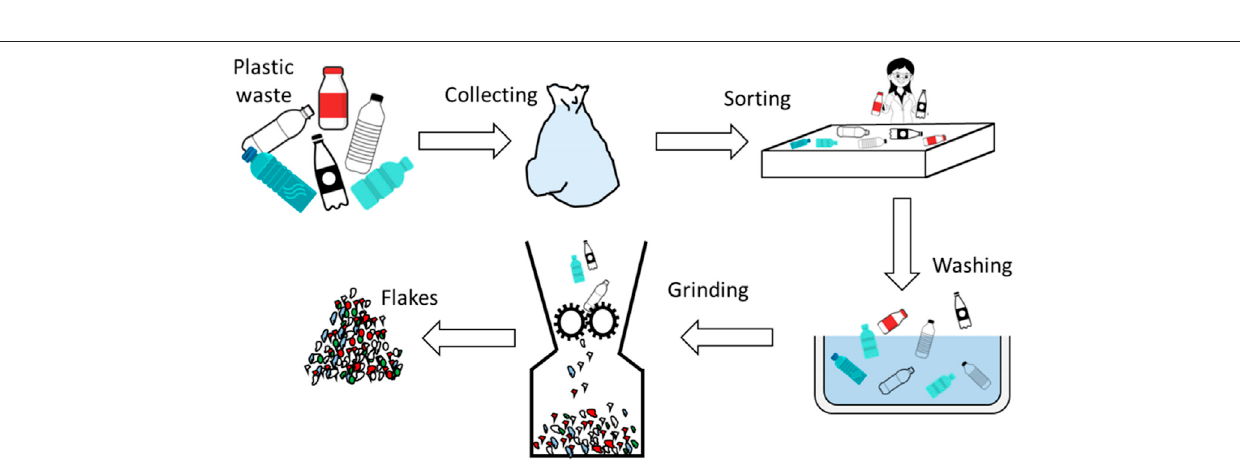
FIGURE 6 | Mechanical recycling for plastic wastes (Ragaert,